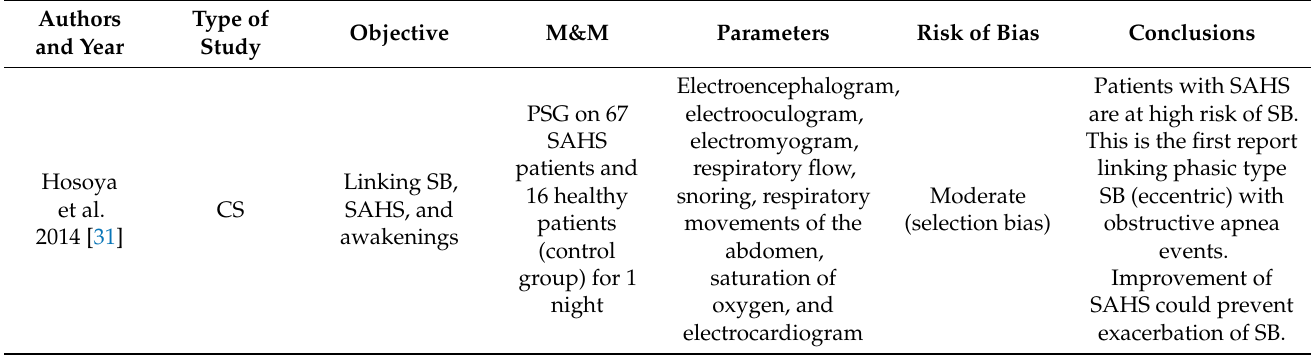
Table 2. Clinical studies analyzing pathophysiological relationships between SB and